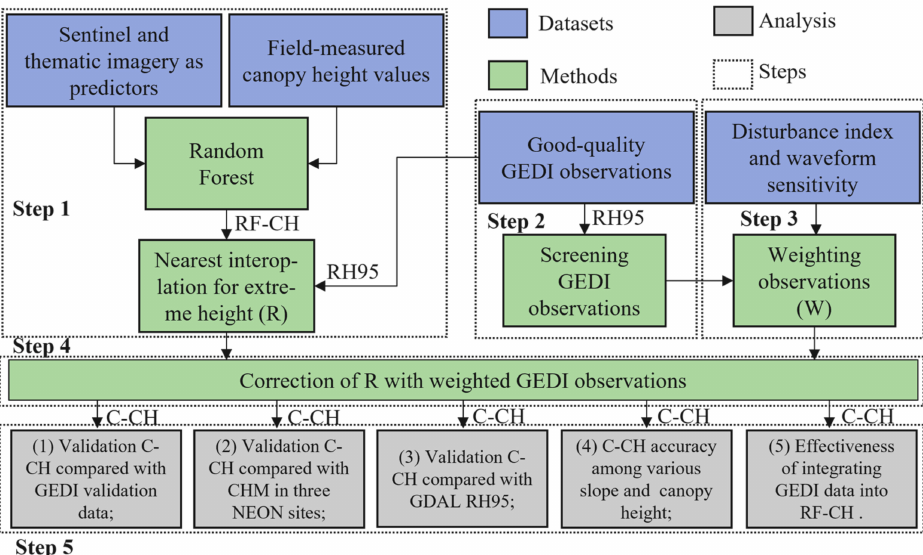
Figure 1. Flowchart of the FPSF-CH and its performance analysis. The RF-CH, RH95, and C- CH are canopy heights derived from RF, GEDI waveform, and the FPSF-CH. R and W are the nearest interpolation dataset and weight for each GEDI data point, respectively. CHM is the canopy height